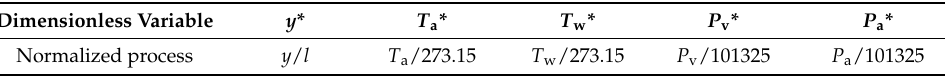
Table 3. Dimensionless variables for correlation